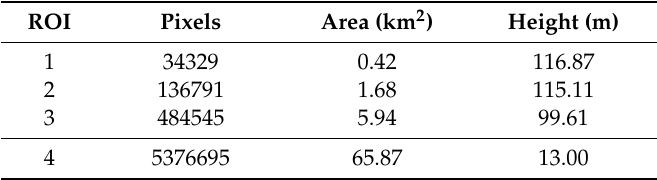
Table 2. Sizes and heights of ROIs.